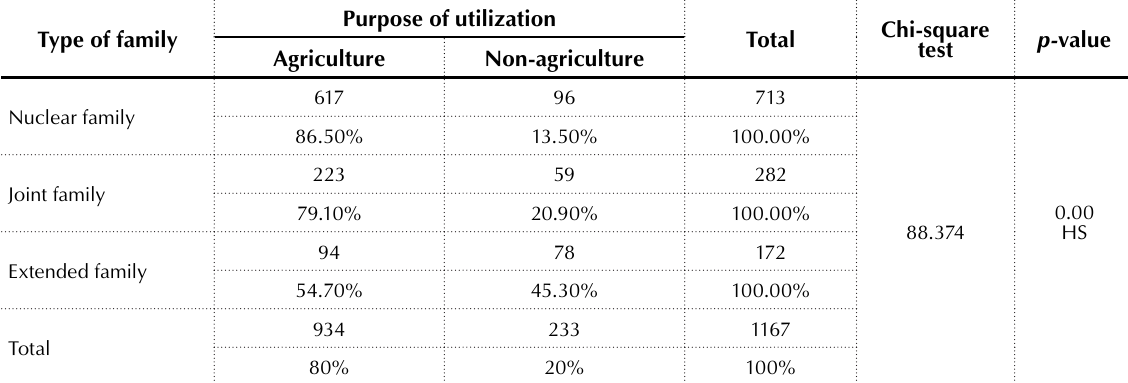
Table 9. Impact of type of family on the purpose of agricultural credit utilization